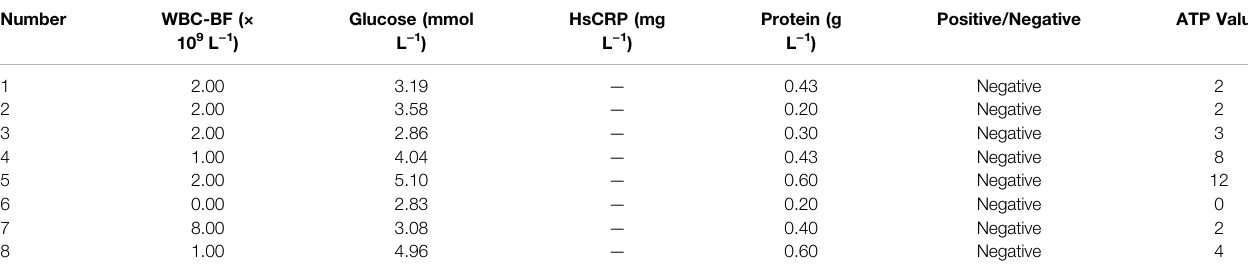
TABLE 2 | Data on CSF samples from eight patients without intracranial